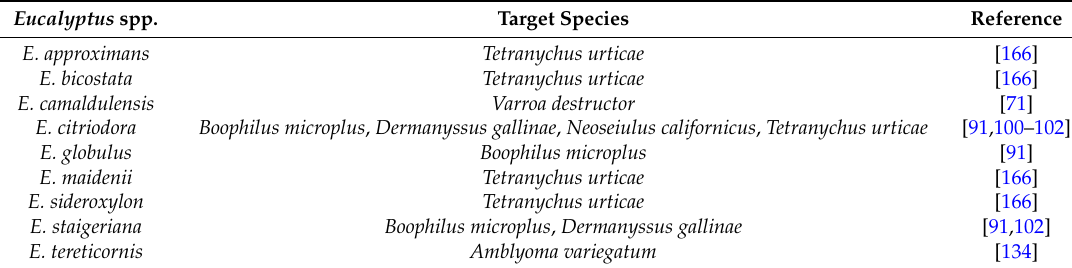
Table 4. Eucalyptus spp. essential oils with acaricidal